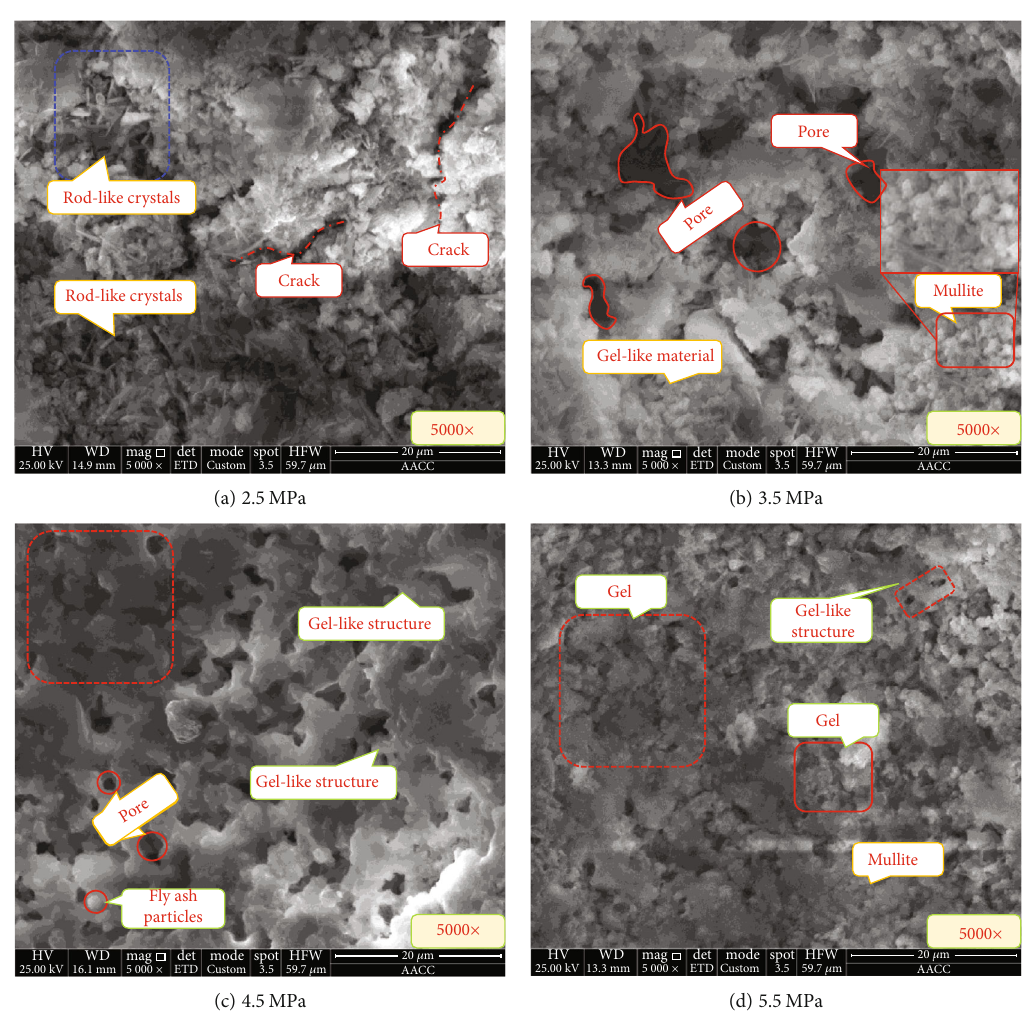
Figure 12: SEM patterns of the SBCB under di ff erent axial